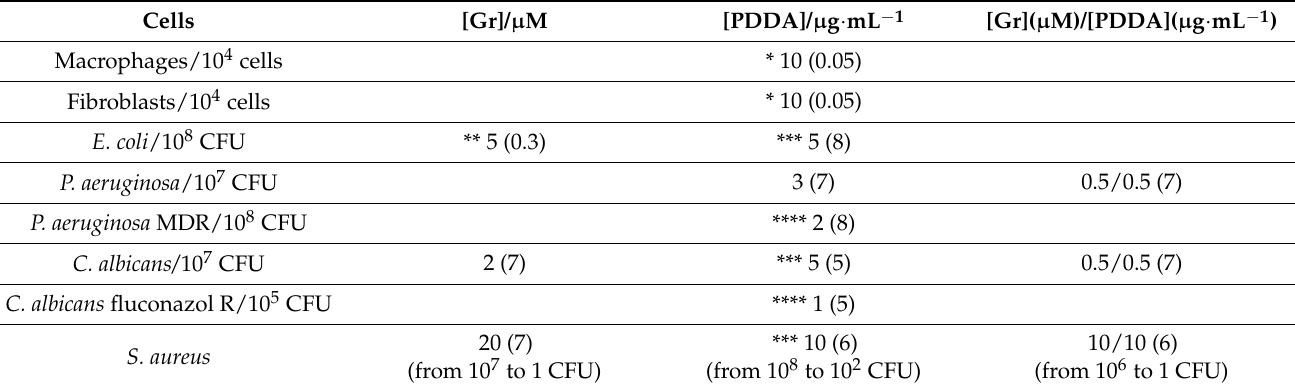
Table 2. Differential cytotoxicity of Gr NPs, PDDA, and Gr NPs/PDDA combinations. The minimal microbicidal concentration (MMC) of each antimicrobial agent by itself or in dual combinations is given for Gr in µ M and for PDDA in µ g · mL − 1 . The reduction in cell viability is expressed as the number of logarithmic cycles (in between parentheses) besides each MMC. Asterisks refer